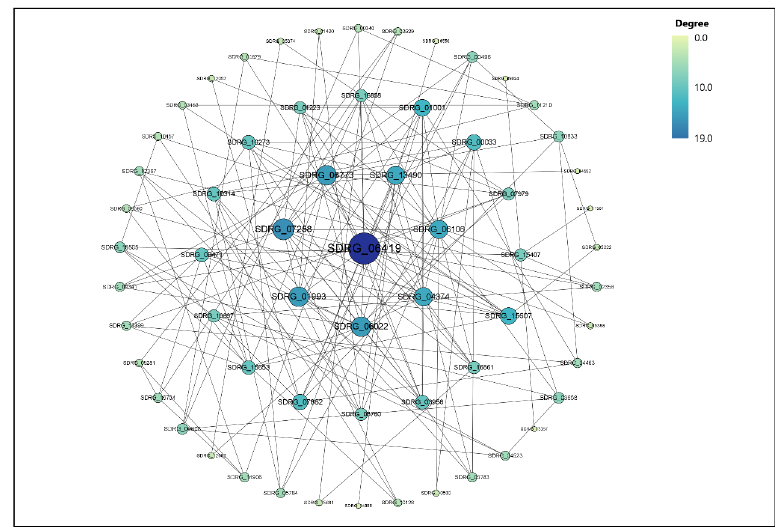
Figure 6. The DEGs in the protein–protein interaction networks are presented as nodes. Node’s name is the protein’s name. The size and color of the node are proportional to the degree of the node. Genes 2022 , 13 , x FOR PEER REVIEW